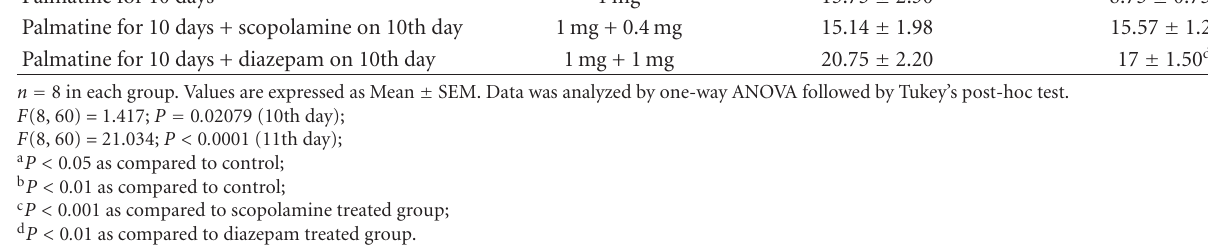
Table 2: E ff ect of palmatine and other drugs employed on escape latency (EL) of mice using Morris water maze. Treatments Control (vehicle) for 10